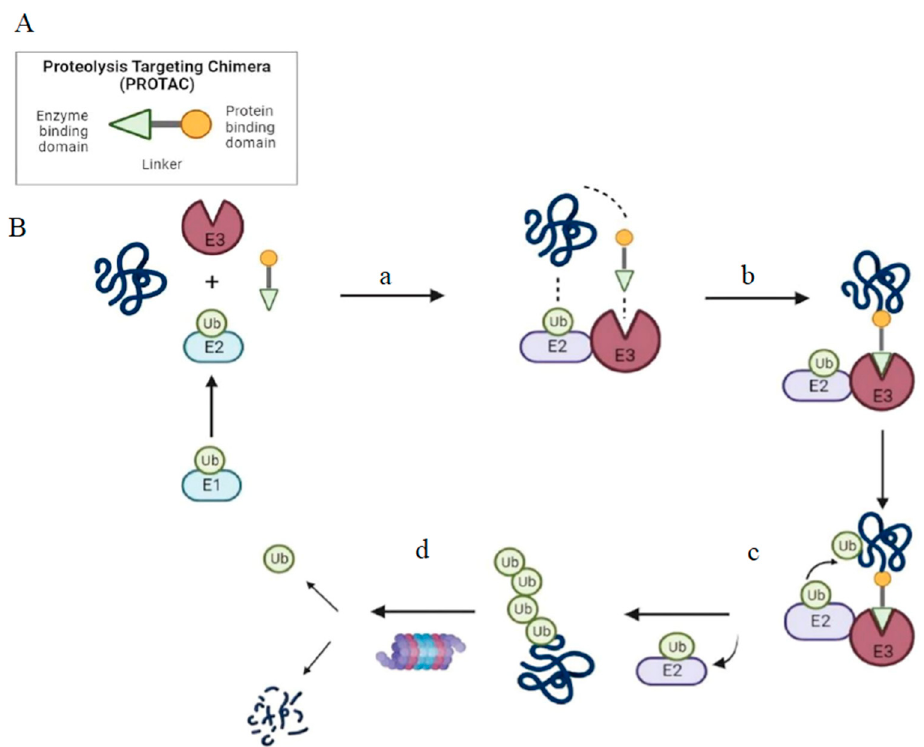
Figure 1. Structure and mechanism of PROTAC-based degradation. ( A ) General structure of a PROTAC: The E3 ligase targeting “anchor” (green) is connected to the specific POI targeting warhead (yellow) via a variable linker; ( B ) Mechanism of PROTAC-mediated target degradation (a) Ub transfer from E1 to E2, which is followed by complex formation with an E3 ligase; (b) the PROTAC binds to both the E3 ligase and POI to form a TC. This brings the E2 ligase into proximity to the POI; (c) this leads to the transfer of multiple Ub units to surface-exposed lysine residues; (d) the resulting polyubiquitin chain is recognized by the proteasome, leading to the proteolytic degradation of the POI . Ub, Ubiquitin; POI, Protein of interest; TC, Ternary complex.